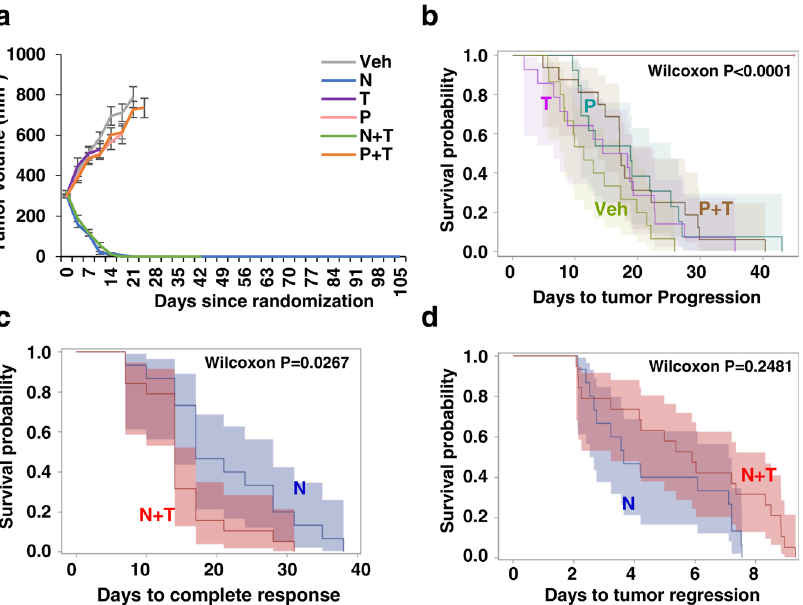
Fig. 2 Neratinib (N) containing anti-HER2 regimens effectively achieve tumor regression and eradication in a patient-derived xenograft model that is refractory to trastuzumab (T) and pertuzumab (P). a Average growth curves of tumors treated with Vehicle, N, T, P, N + T, or P + T ( n = 13 – 19). Results are presented as mean tumor volume ± SEM. Kaplan – Meier analysis of b time to tumor progression in mice treated with different anti-HER2 therapies, and c time to complete response and d time to tumor regression in mice treated with N or N + T. Shaded areas represent point-wise 95% con fi dence regions, calculated using the loglog transform. P values are indicated on plots, Wilcoxon test. Veh